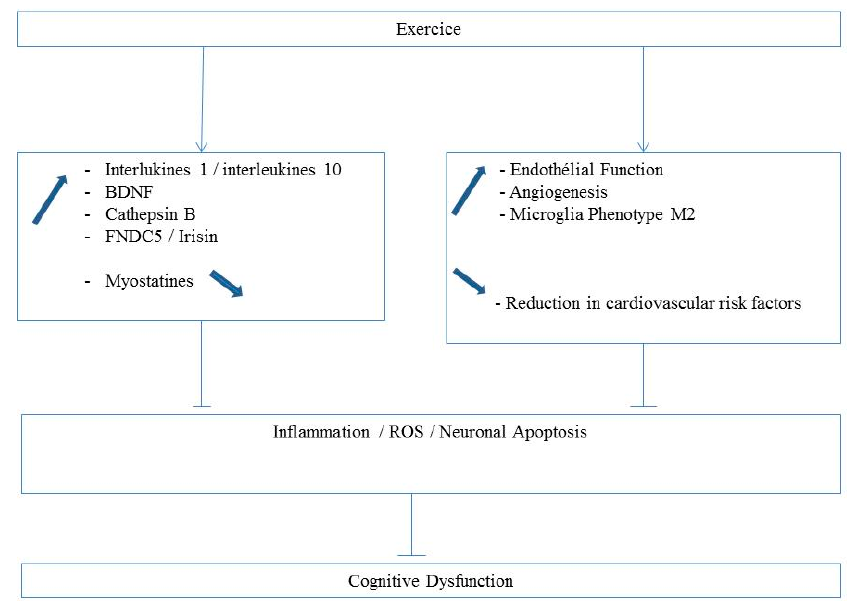
Figure 3. Mechanisms likely involved in exercise-related brain protection in PAD patients.